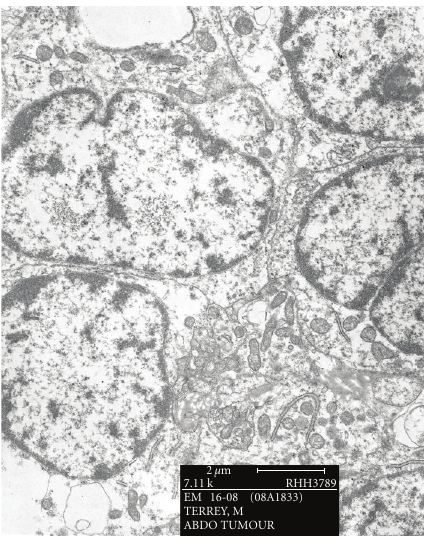
Figure 3: Electron microscopy showing sparse cytoplasmic organelles with short strips of rough endoplasmic reticulum and